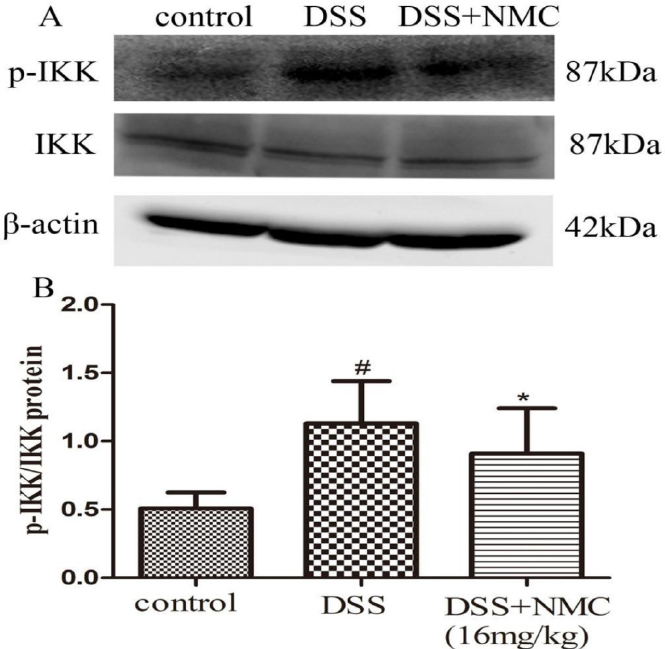
Figure 6. Effects of NMC on the expression of p-IKK and IKK in DSS-induced colitis. ( A ) the expression of p-IKK and IKK in colon tissue were determined using Western blotting. ( B ) the relative quantification of p-IKK and IKK protein expression calculated by using Image J software. Data are expressed as mean ( n = 10 per group) ± SEM. # p < 0.5 compared with control group; * p < 0.05 compared with the DSS-vehicle group.